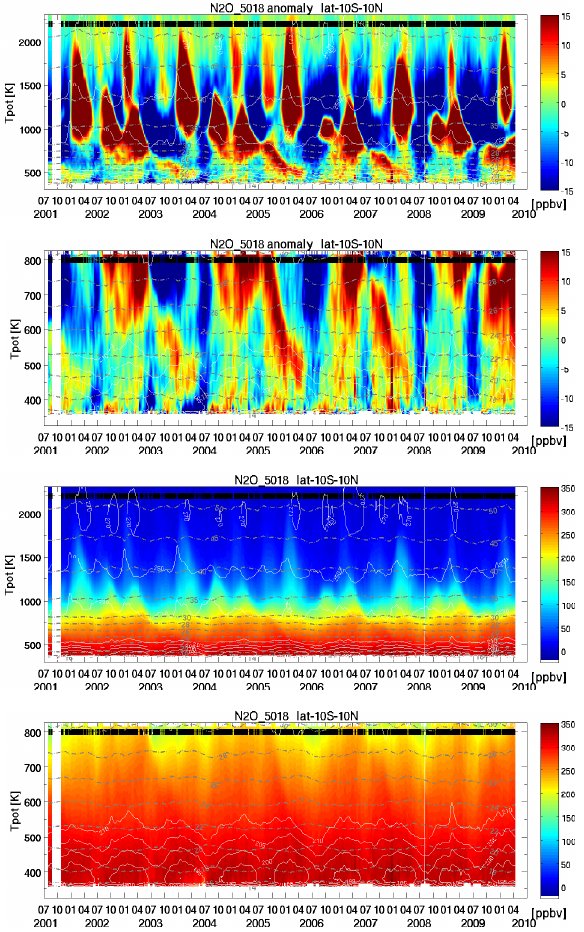
Fig. 8. Top and second row: Odin/SMR N 2 O anomaly (daily zonal mean minus multi-year zonal mean) for the years 2001–2010 for the entire stratosphere and lower stratosphere for the latitude range 10 ◦ N–10 ◦ S, respectively. Third row and bottom: N 2 O mean for the years 2001–2010 for the entire stratosphere and lower stratosphere for the latitude range 10 ◦ N–10 ◦ S. Altitude and temperature (from ECMWF) are given as grey and white lines, respectively.